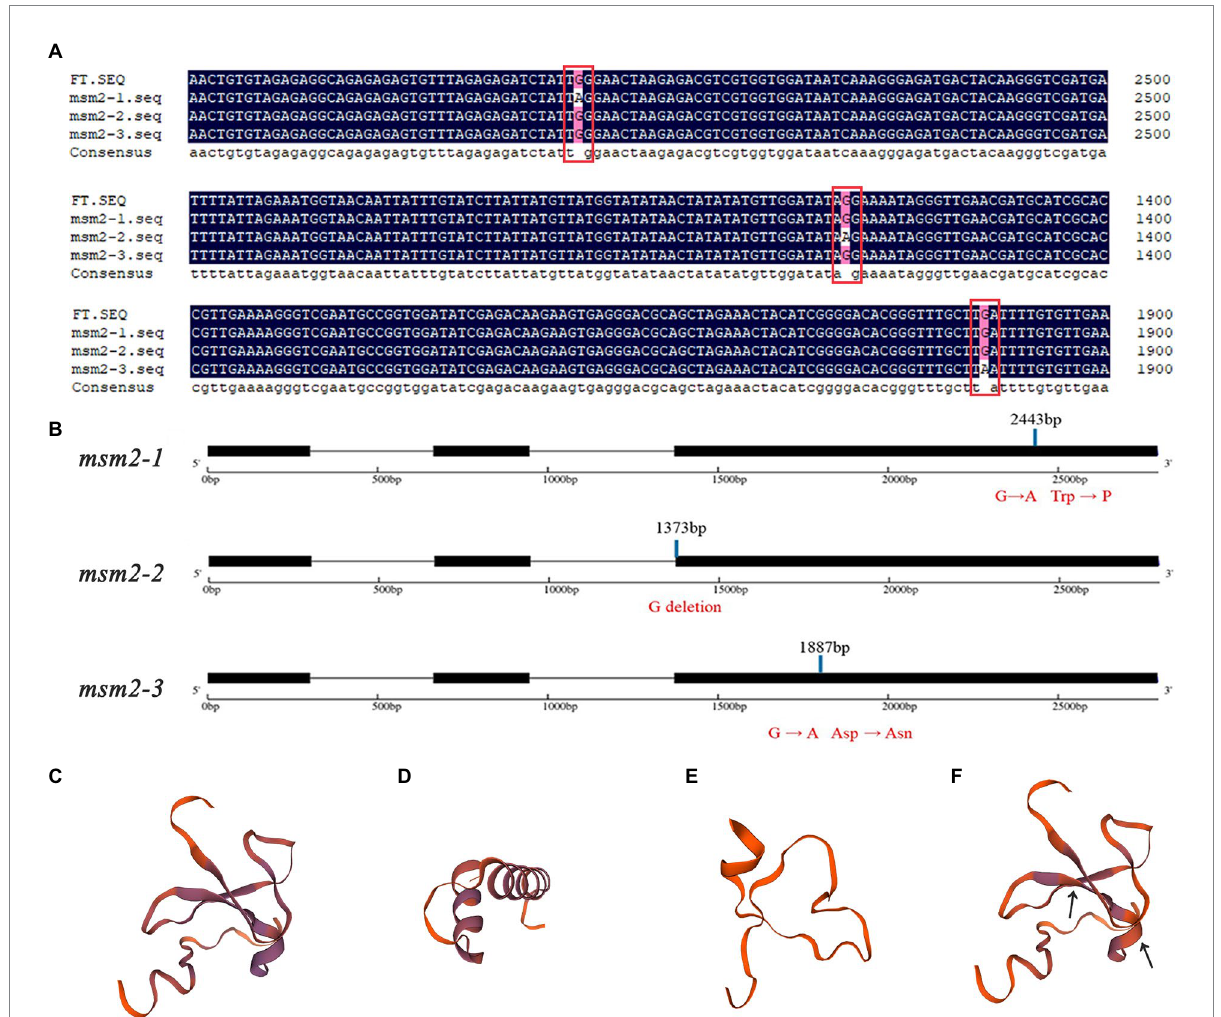
FIGURE 6 Sequence alignment and structure analysis of BrMS1 between the wild-type “FT” and msm2-1/2/3 mutants. Comparison of the BraA10g019050.3C nucleotide sequence (A) and structure (B) between the wild-type “FT” and msm2-1/2/3 mutants. Three-dimensional protein structure